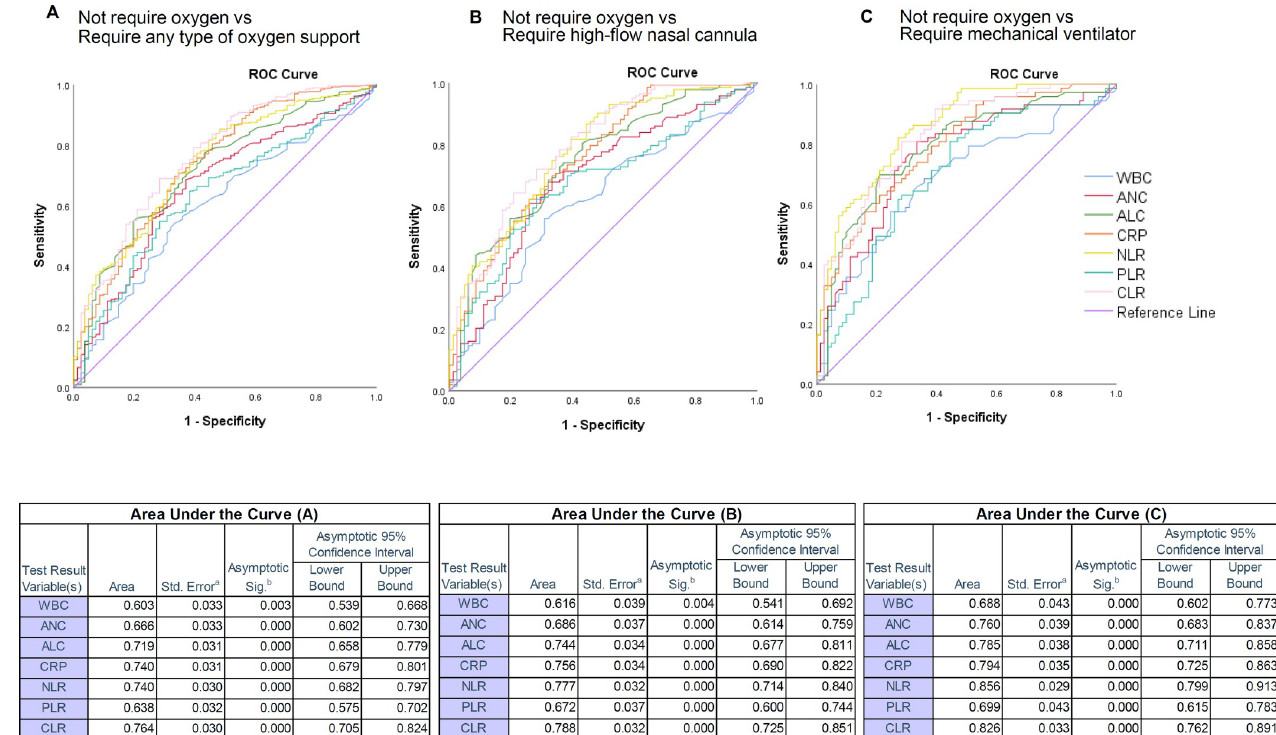
Fig 3. Receiver operating characteristic (ROC) curve analysis of routine laboratory and novel markers for oxygen support requirements. (A) The AUC of white blood cell count (WBC), absolute neutrophil count (ANC), absolute lymphocyte count (ALC), C-reactive protein (CRP), neutrophil/lymphocyte ratio (NLR), platelet/lymphocyte ratio (PLR) and C-reactive protein/lymphocyte ratio (CLR) for requiring any type of oxygen support was 0.603, 0.666, 0.719, 0.740, 0.740, 0.638 and 0.764 respectively. The ROC analysis showed the highest AUC value in CLR for the requirement of any type of oxygen. (B) The AUC of WBC, ANC, ALC, CRP, NLR, PLR and CLR for requiring oxygen support with high-flow nasal cannula was 0.616, 0.686, 0.744, 0.756, 0.777, 0.672 and 0.788, respectively. The CLR had the greatest AUCs for guiding oxygen therapy with a high-flow nasal cannula. (C) The AUC of WBC, ANC, ALC, CRP, NLR, PLR and CLR for need of mechanical ventilator was 0.688, 0.760, 0.785, 0.794, 0.856, 0.699 and 0.826, respectively. The ROC analysis showed the highest AUC value in NLR and CLR for guiding mechanical ventilator treatment.